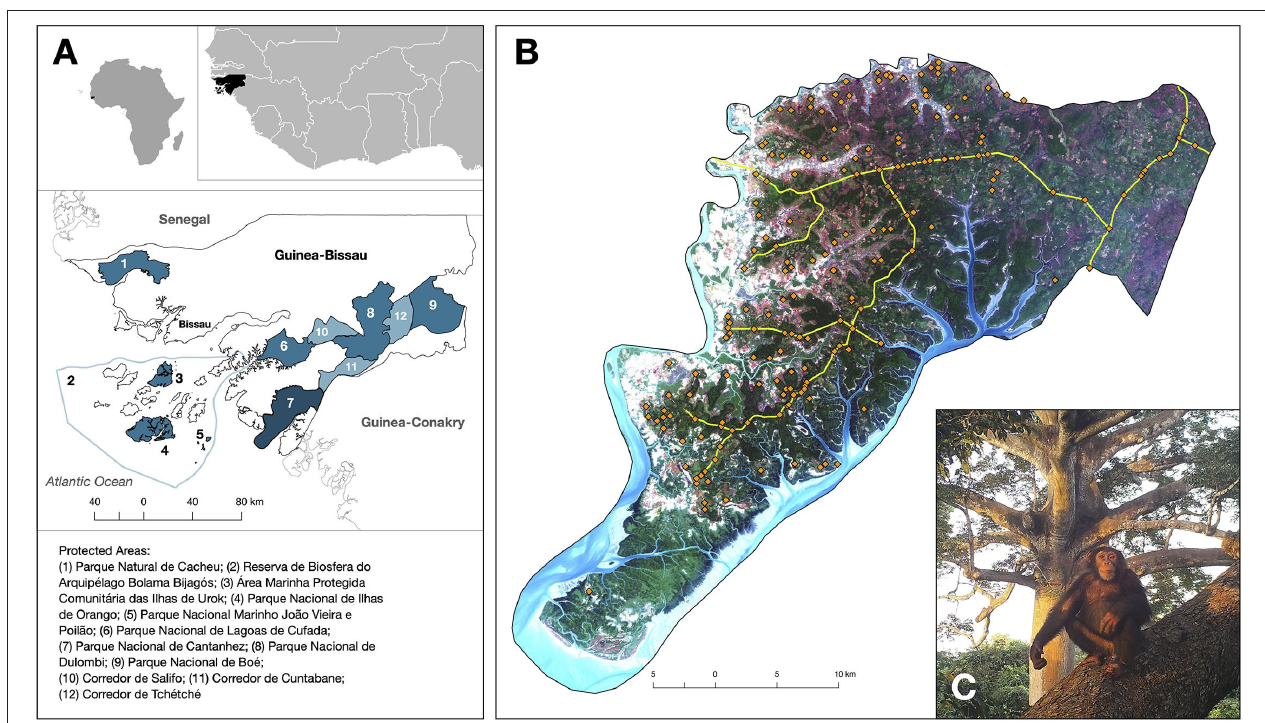
FIGURE 1 | (A) Guinea-Bissau (36,125 km 2 ) hosts a network of marine and terrestrial Protected Areas, including Cantanhez National Park shown in dark blue; (B) Cantanhez National Park roughly corresponds to the Bedanda Sector (24,293 inhabitants in 2009), administrative designation for the Cubucaré peninsula, located in the Tombali Region. Cantanhez National Park includes a road network and about 200 villages and settlements of varying sizes, from about 10 to over 1,000 inhabitants; (C) the Critically Endangered western chimpanzee is a national flagship species in Guinea-Bissau. Cantanhez National Park hosts ∼ 10 chimpanzee communities across protected forest fragments. The map of Cantanhez National Park contains modified Copernicus Sentinel data from 2017 processed by Sentinel